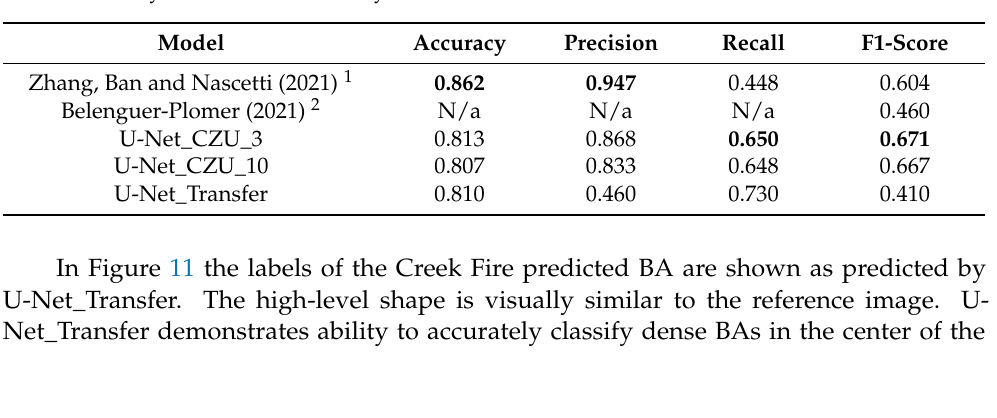
Table 7. Creek Fire Transfer Learning Segmentation Results: 1 Based on the U-Net with Learning without forgetting with SAR based reference mask for the Sydney Fire (2019-2020). 2 Based on North American study area S-1 satellites